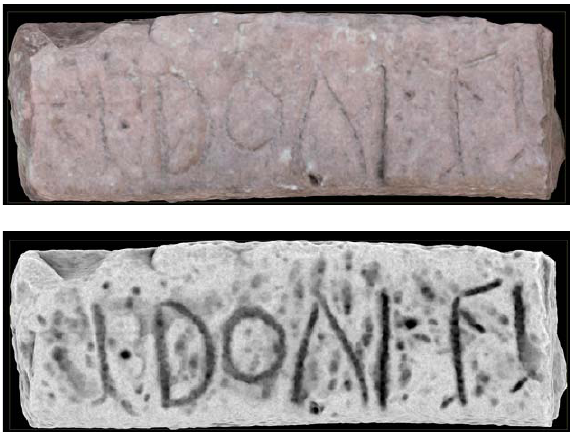
Figure 10: Mesh and neutral rendering of architectural blocks